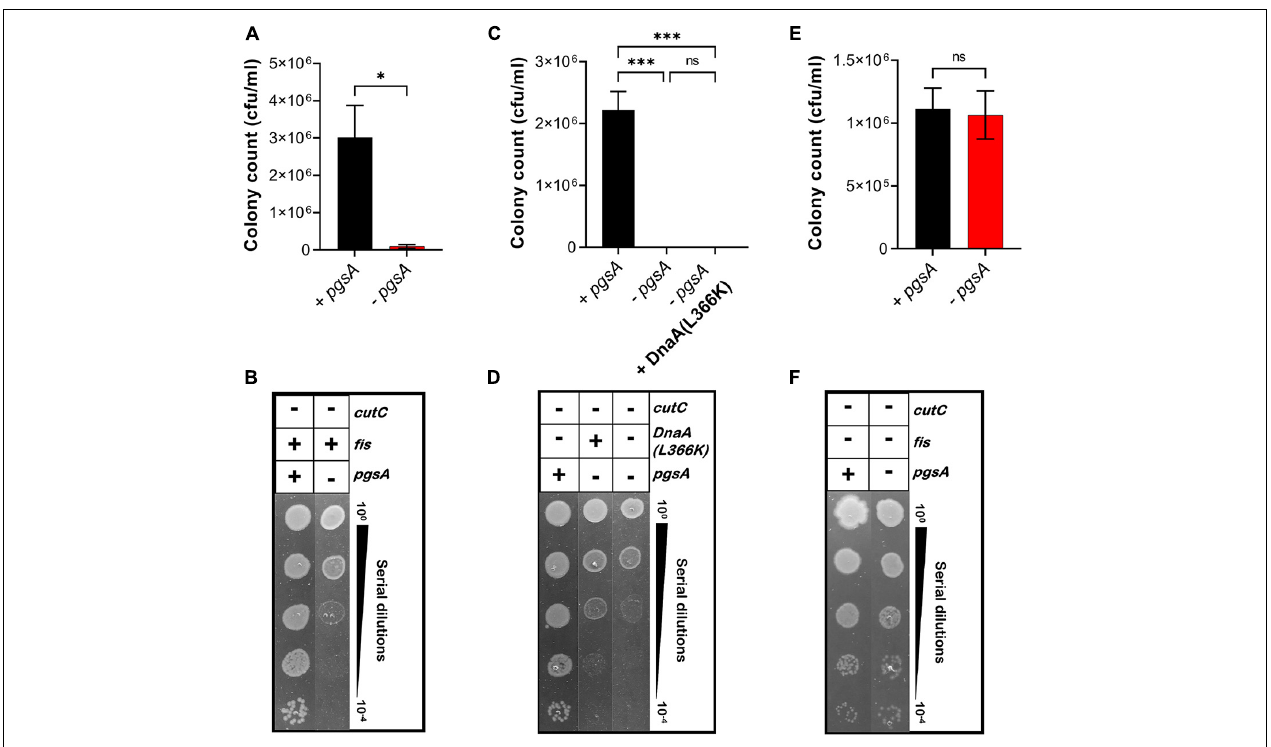
FIGURE 8 | Growth of fis-null cells lacking promoter for MicL-S small RNA does not depend on cellular levels of acidic phospholipids. (A,B) Viability of MDL12 cutC-null cells treated with 1 mM IPTG for the expression of pgsA (black), no inducer control (red) in M9+CAA+Glu medium. (C,D) Viability of MDL12 cutC-null fis-null cells treated with 1 mM IPTG for the expression of pgsA (black), no inducer control (red) in M9+CAA+Glu medium. (E,F) Viability of MDL12 cutC-null cells carrying plasmid for DnaA(L366K) with 1 mM IPTG for the expression of pgsA (black), no inducer control (red), and 0.2% Arabinose control (blue) in M9+CAA+Glu medium. Viability is expressed in cfu/ml and presented on a linear scale. Data are means ± SEM of at least three independent experiments. ∗ p < 0.05, ∗∗∗ p < 0.001, ns p > 0.05 in Student’s t -test for analysis in plots A and C, and one-way ANOVA with Dunnett’s multiple comparison